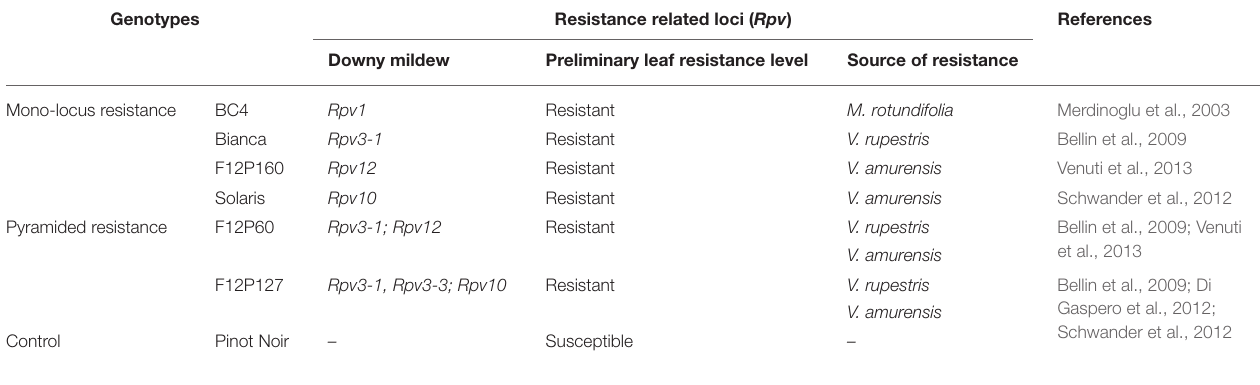
TABLE 1 | The genotypes used in this study, their source of resistance and their associated resistance-related loci ( Rpv ) with their references. Genotypes